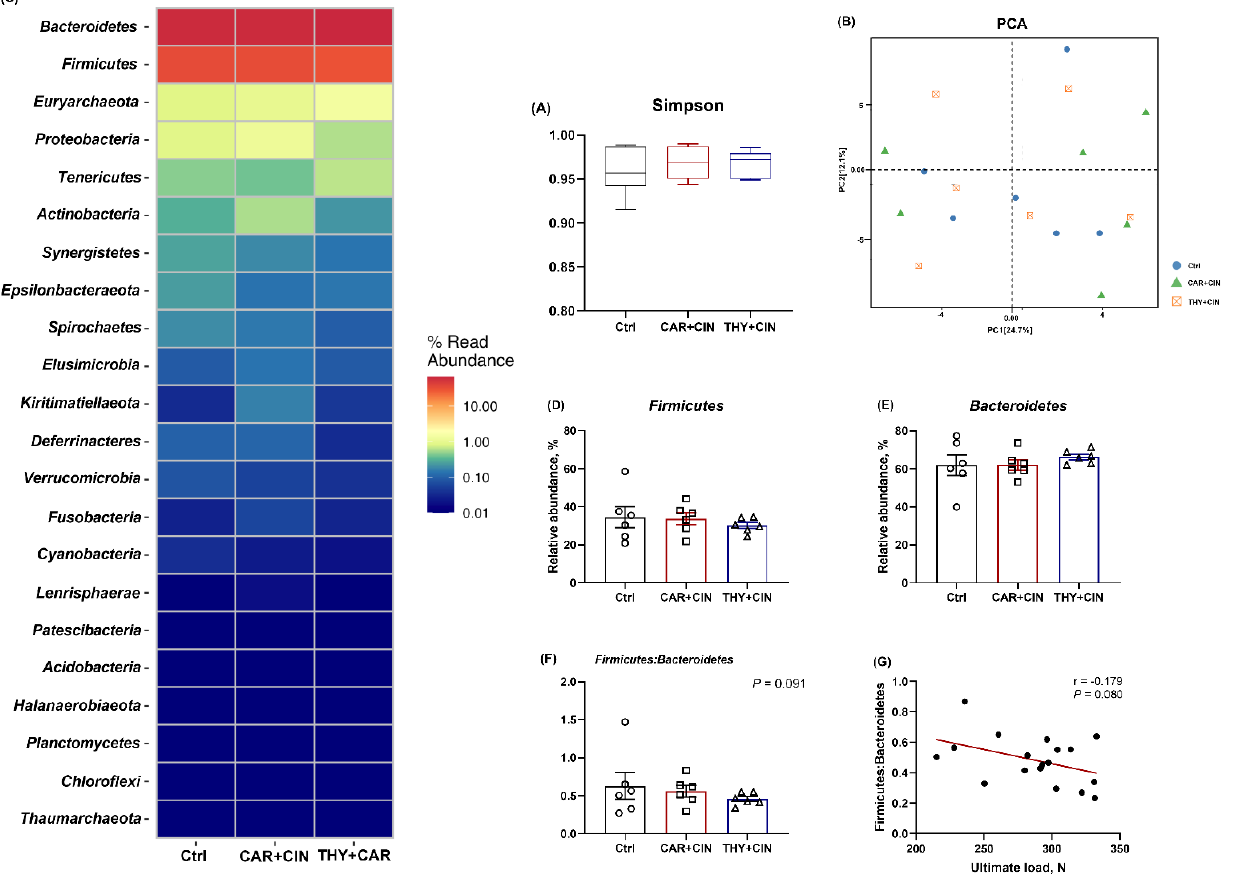
Figure 4. Impacts of the combination of cinnamaldehyde with carvacrol (CAR+CIN) or thymol (THY+CIN) on cecal microbiome of laying hens. ( A ) Simpson indexes was used to assess alpha diversity, in which boxes are bounded by the 25th and 75th percentiles, with the median shown by the line bisecting the box. ( B ) principal component analysis (PCA) of caecum microbiome diversity, ( C ) relative abundances at phylum level, ( D – F ) the proportion of Firmicutes and Bacteroidetes, and their ratio, ( G ) correlation between Firmicutes: Bacteroidetes ratio and ultimate load. Values are mean ± standard error (SE) represented by vertical bars ( n = 6), and p < 0.05 is defined as statistically significant.